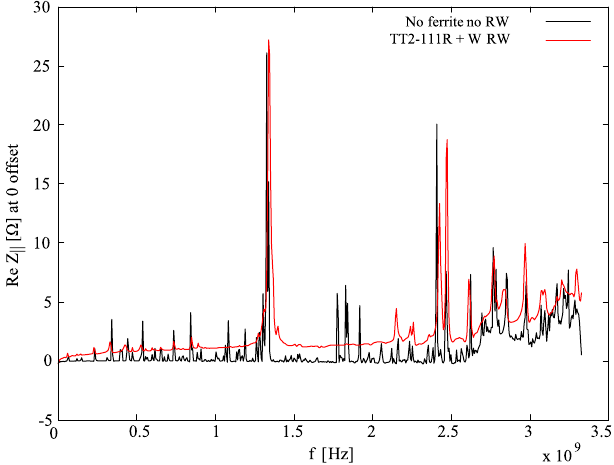
FIG. 4. Longitudinal impedance for the new collimator as computed by G dfid L , with (red curve) and without (black curve) TT2-111R ferrite and tungsten resistive wall (W). No offset is applied.